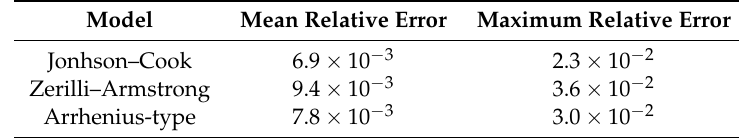
Table 5. Errors in the meta-model predictions of ∆ L compared with full FE